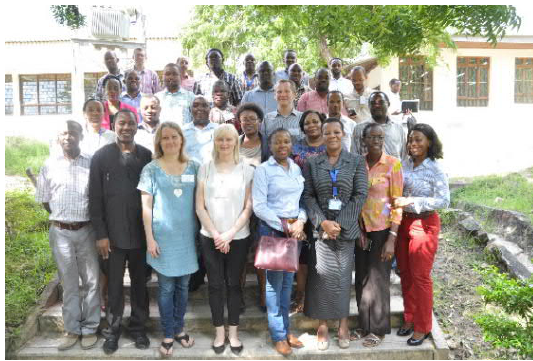
Figure 8. GEO-ICT project kick-off seminar was organised